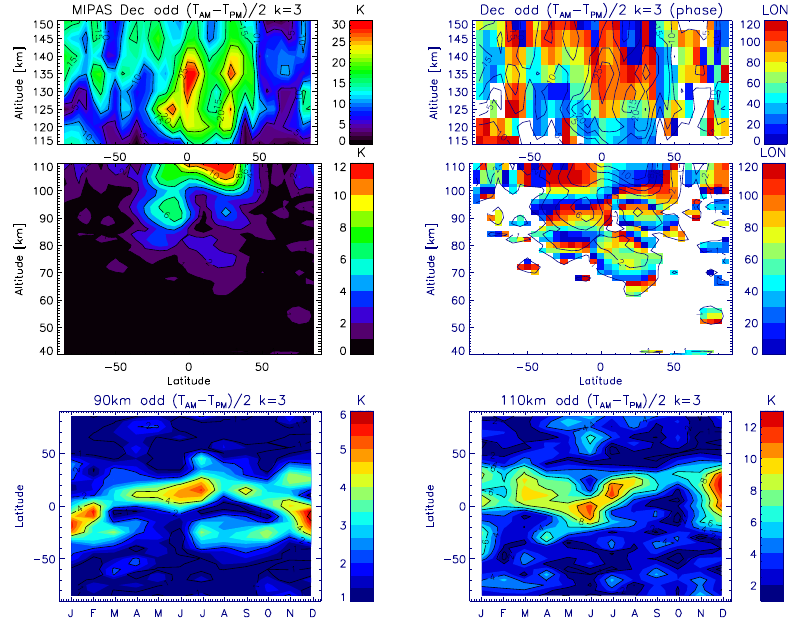
Figure 9. Latitude–altitude amplitude (left) and phase (right) fields for December MIPAS average (2007–2012) | n odd − s | = 3 longitudinal oscillations (first and second row) and average monthly mean time series of | n odd − s | = 3 amplitudes at 90km (left) and 110km (right). Contributions from DE2, DW4 and T0 tides are embedded.